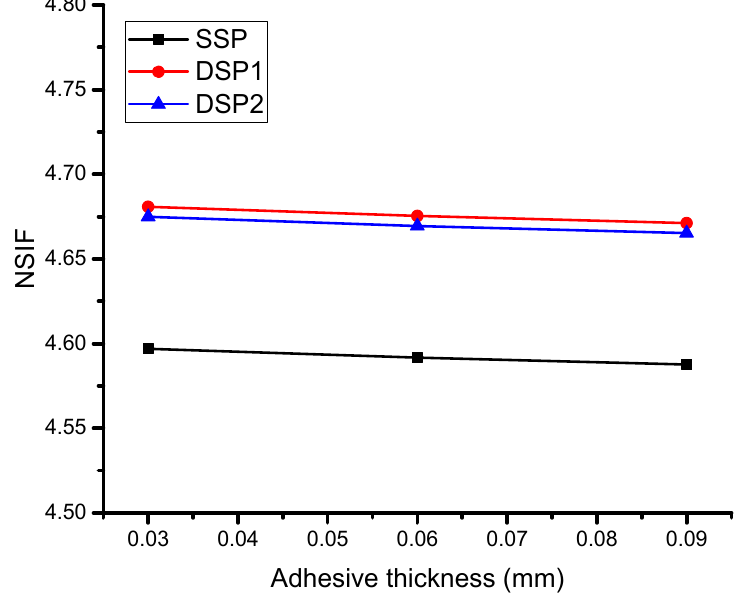
Figure 5. Effect of adhesive thickness.